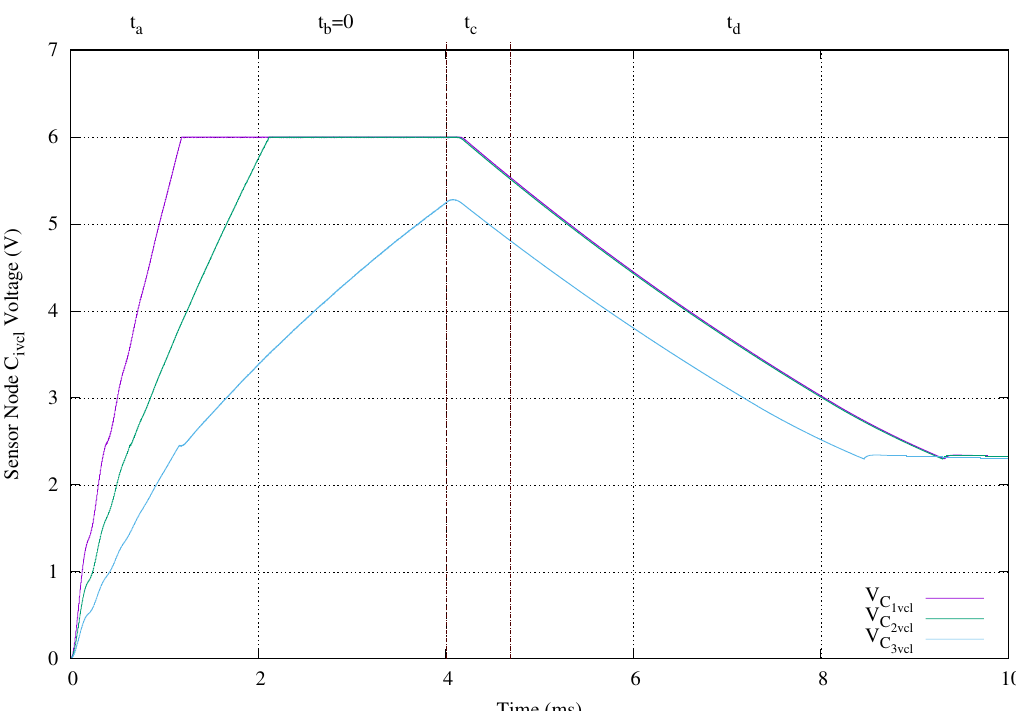
Figure 14. Charge capacitor voltage ( V C there is a cable breakage at C 4 a .